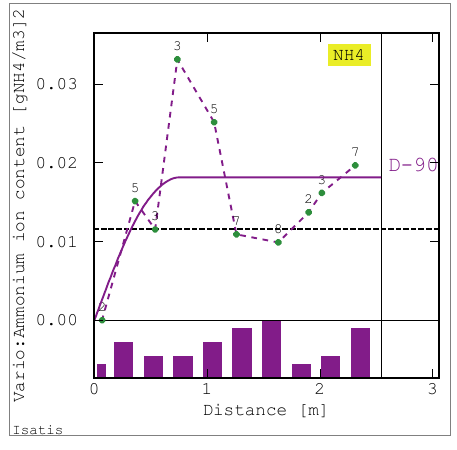
Fig. 18. Directional semivariogram (D-90) of manganese Mn content [g Mn ++ /m 3 ] 2 in underground water in Kłodzko intake area; 14 wells + 3 piezometers